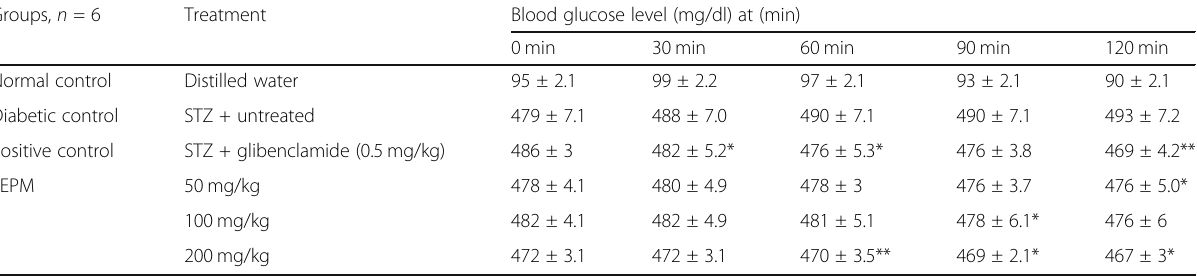
Table 4 Effect of EEPM fruits on oral glucose tolerance test Groups, n = 6